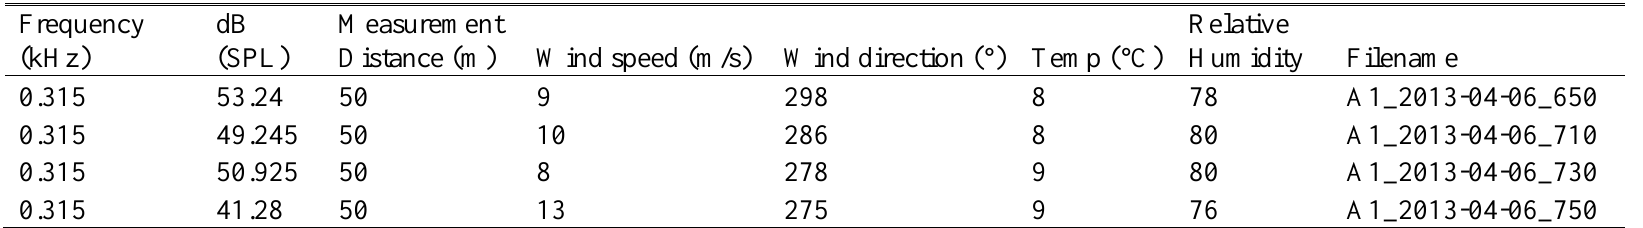
Table A1.1. Example source sound table for SPreAD-GIS from lek recordings on 4/06/2013 at lek A1 near Ainsworth, Nebraska. dB represents average boom chorus sound level in a five minute recording. Weather conditions were recorded at